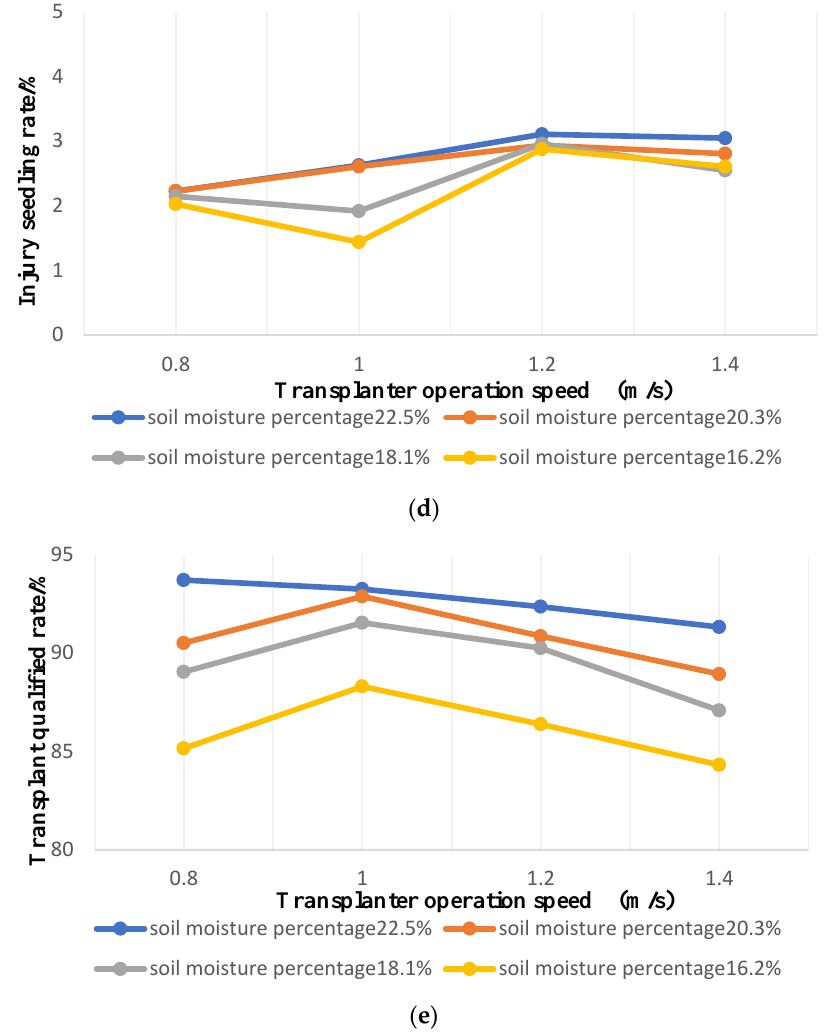
Figure 5. Graph of transplanting effect at different working speeds. ( a ) Line chart of repeat transplanting rate changes under different operating speeds. ( b ) Line chart of seedling lodging rate changes under different operating speeds. ( c ) Line chart of the change of the missing transplanting rate under different operating speeds. ( d ) Line chart of the change of seedling injury seedling rate under different operating speeds. ( e ) Line chart of the change of transplanting qualification rate under different operating speeds.